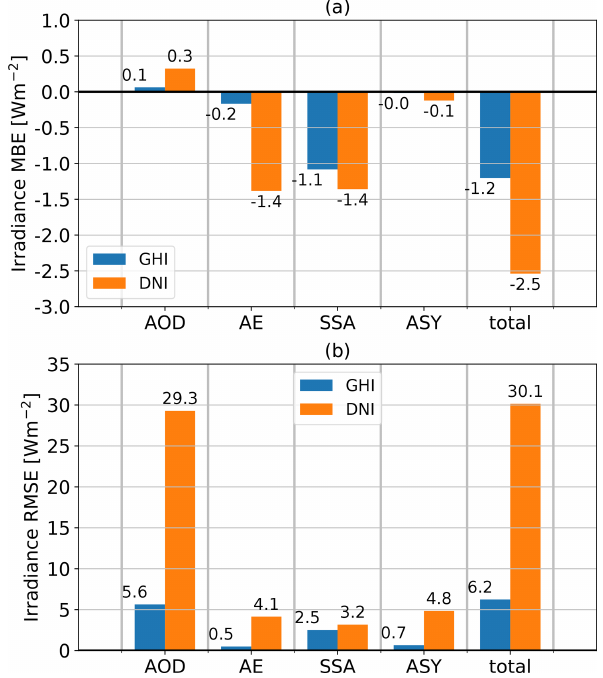
Figure 5. Mean bias (a) and RMSE (b) estimates of simulated GHI (blue) and DNI (orange). The estimates are computed from irra- diance kernels weighted by MBE and RMSE of the CAMS RA aerosol optical properties compared to the AERONET aerosol prod-